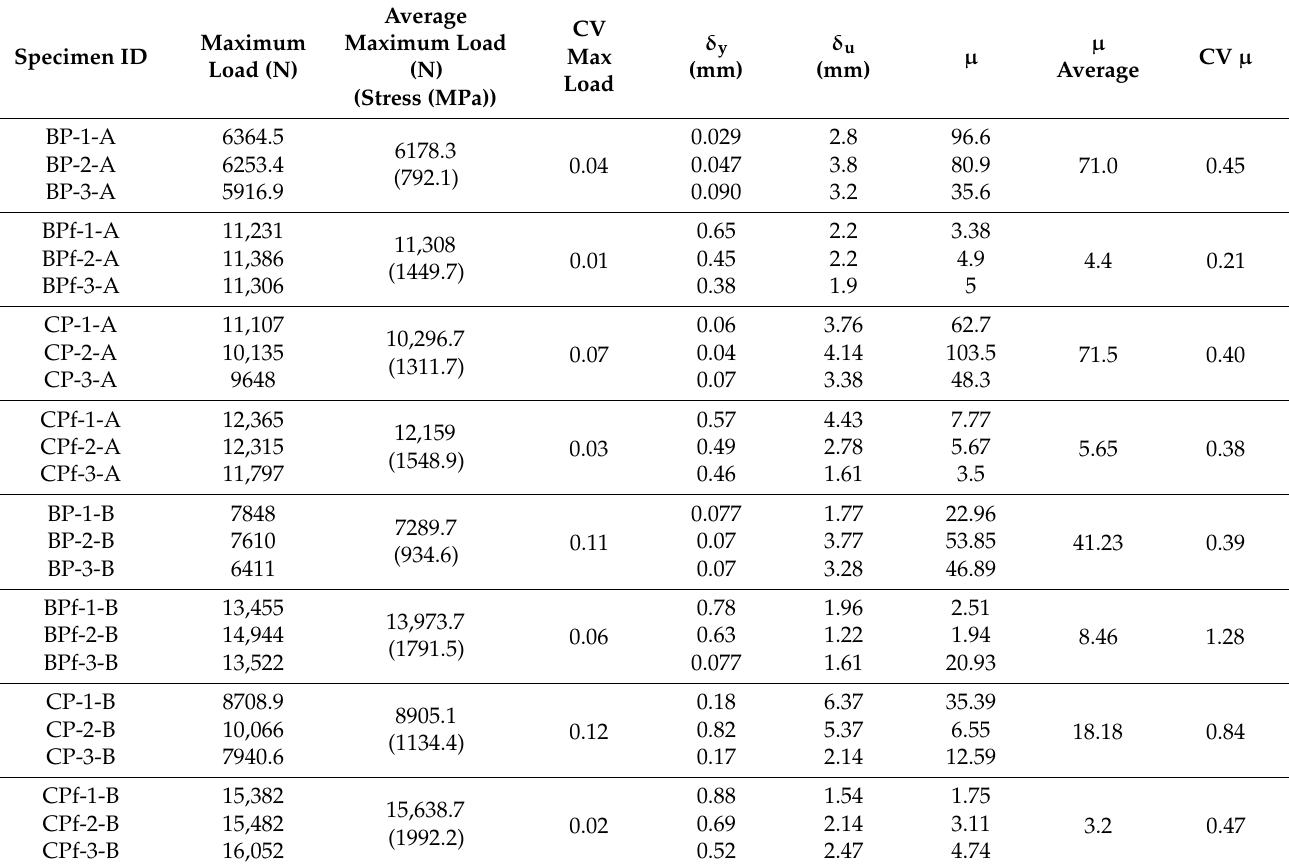
Table 4. Test results expressed in terms of average maximum load, equivalent yielding displacement, ultimate displacement and index of inelastic